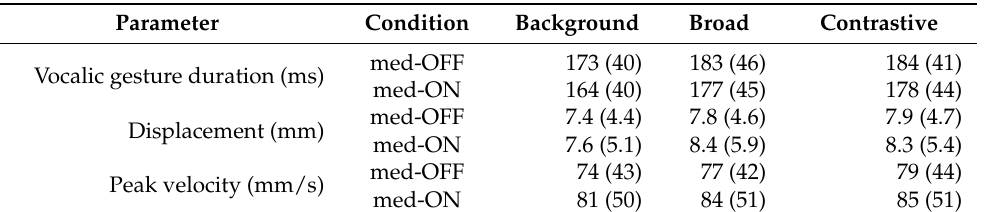
Table 4. Means and standard deviations for articulatory parameters of interest depending on prominence condition and medication condition.